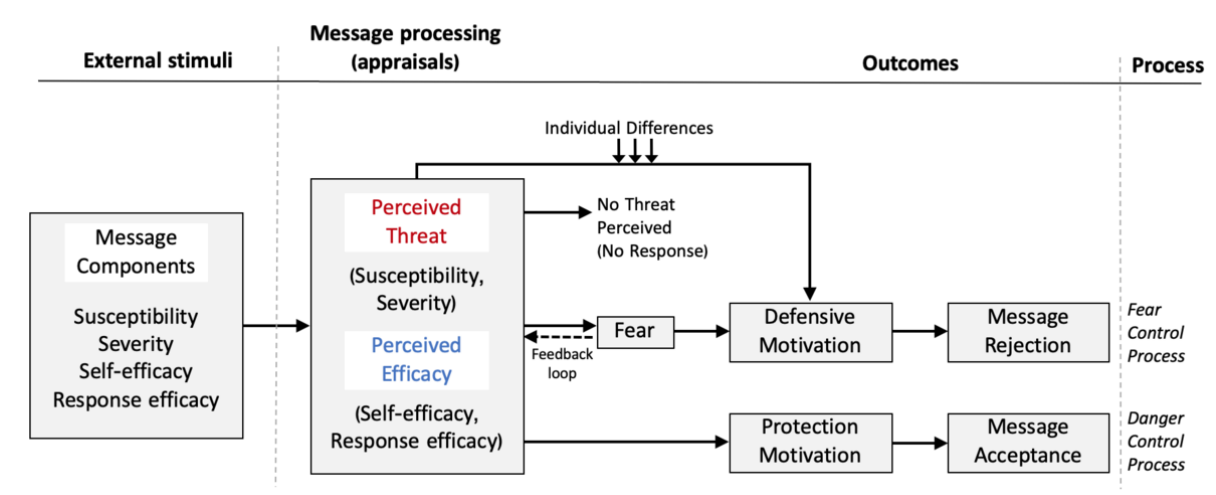
Figure 1. Extended Parallel Process Model, adapted from